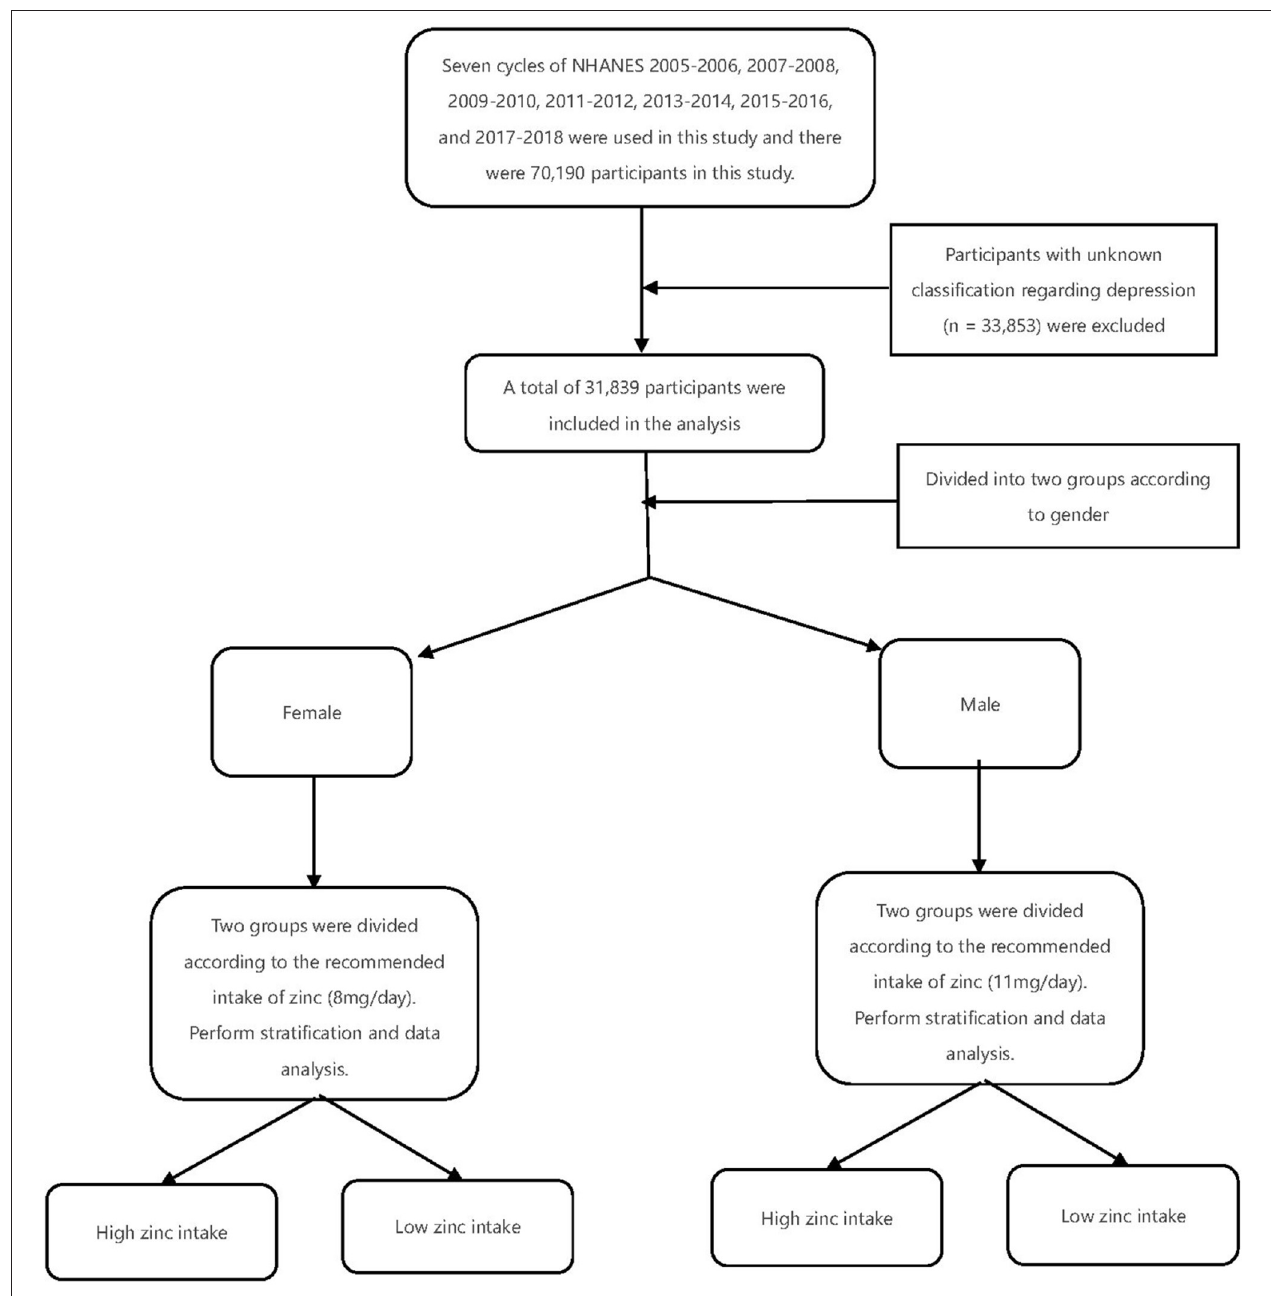
FIGURE 1 | Experimental methods and